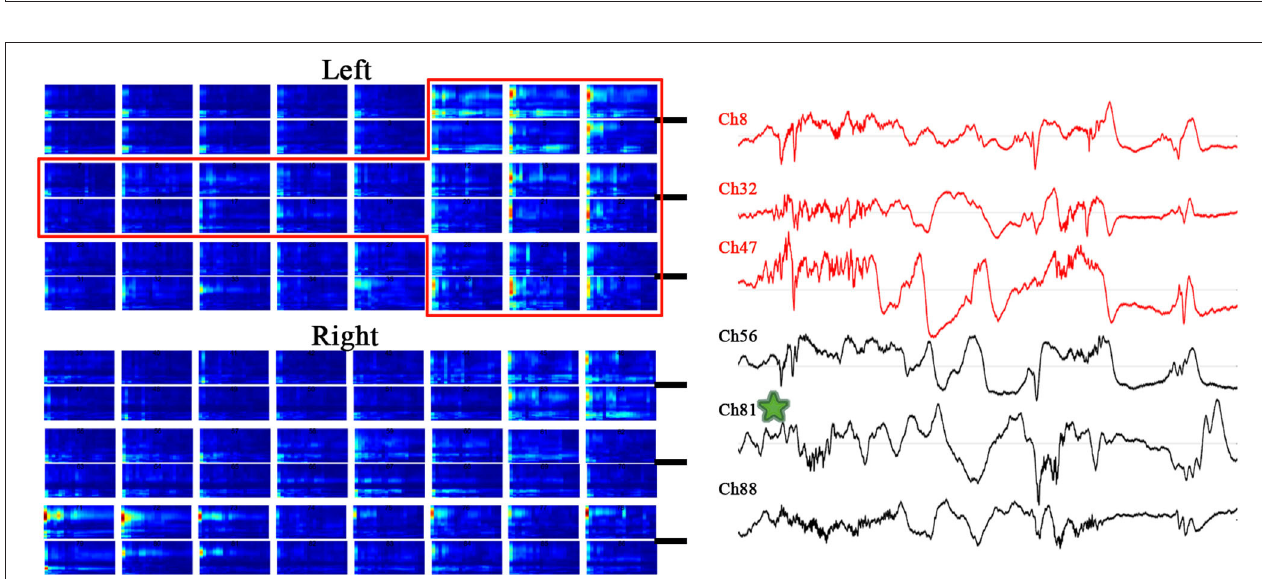
FIGURE 5 | MI co-modulogram and original EEG during PS 10 of special case F. The red rectangle is the excised area; the strongest PAC channel is mark by green star. Although some strong PAC channels on the contralateral cortex of the resection area, the strong PAC channels in the contralateral cortex were not centralized than that in the resection area, and the slow wave of raw ECoG on the contralateral cortex was more significant than that on the resection side.